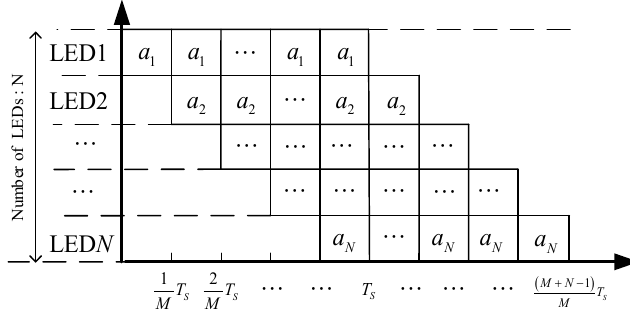
Figure 3. The codeword structure of the ML-MTSC scheme.